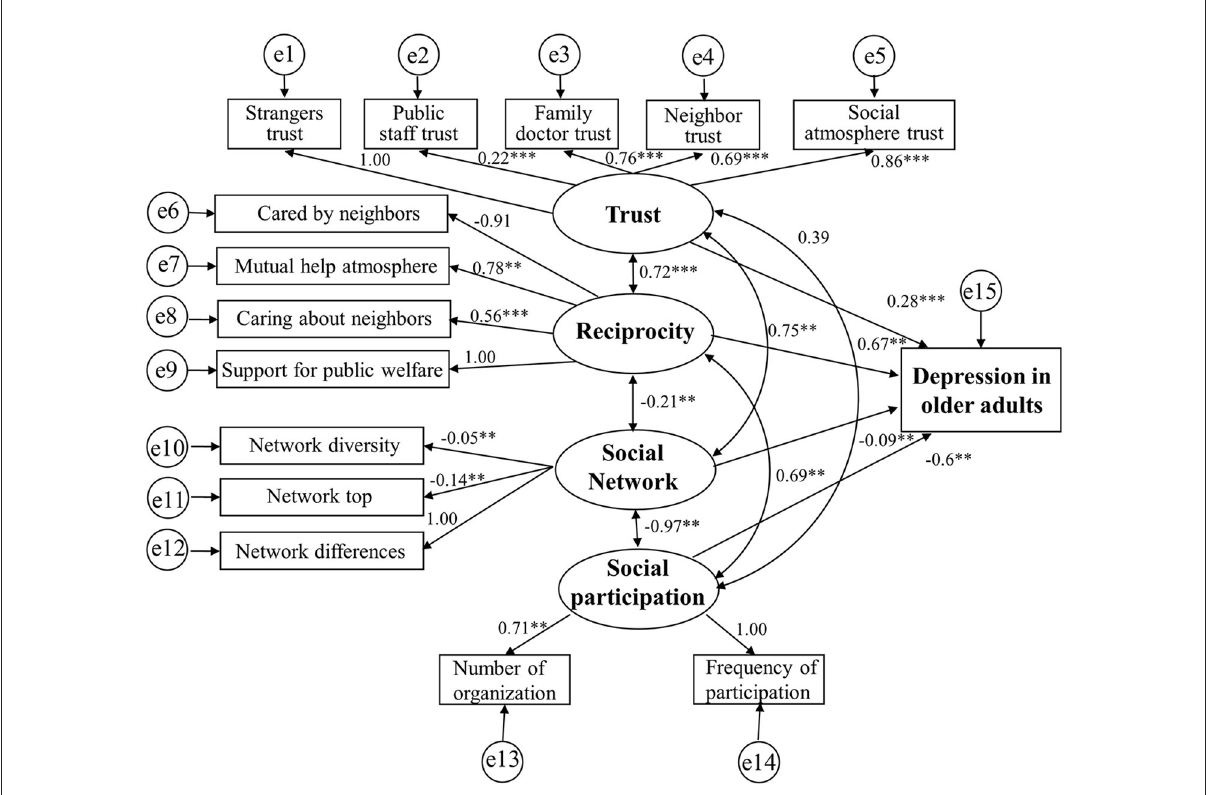
FIGURE4 The relationship between social capital and depression in female